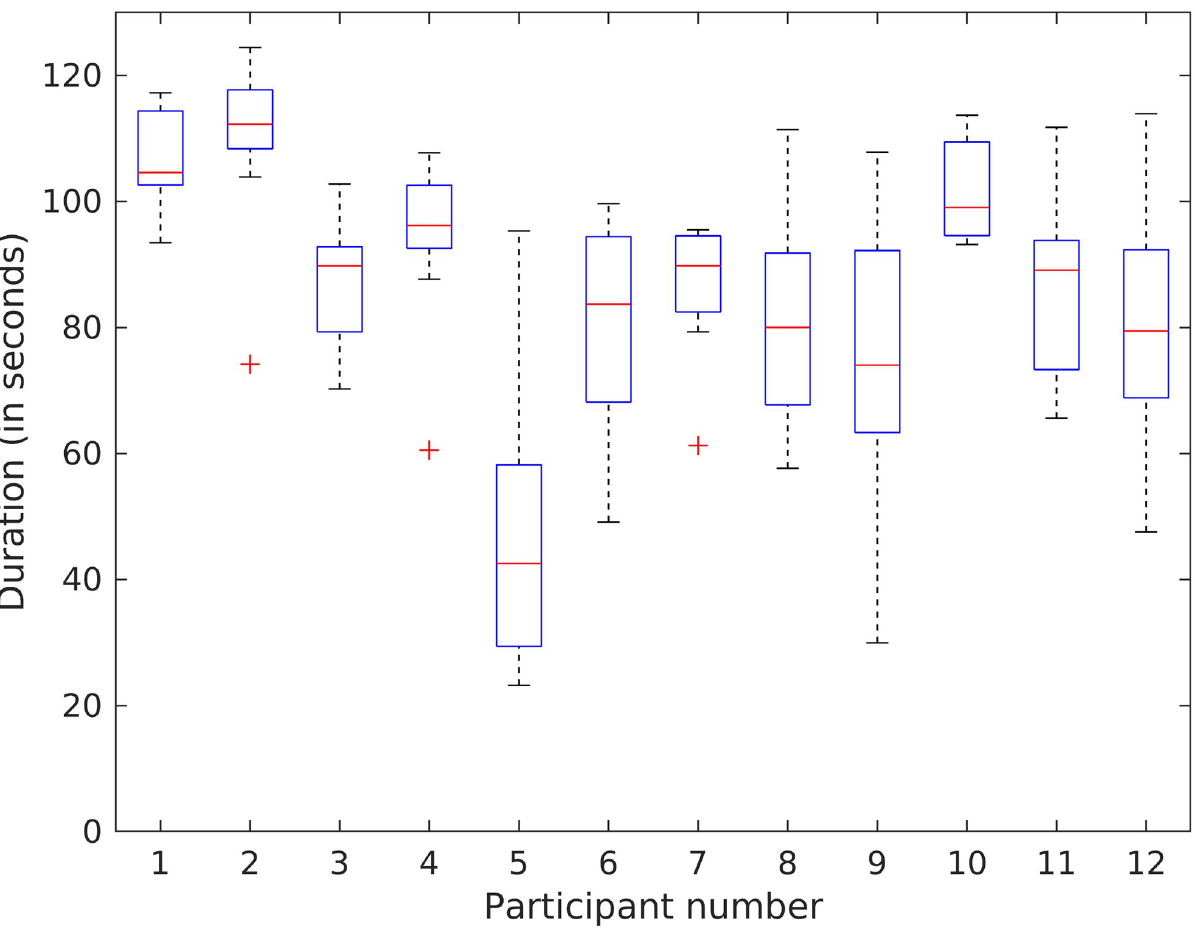
Fig 2. Brushing durations for the 12 participants. Active brushing duration is calculated by excluding pauses in brushing and the times transitioning the brush head to different